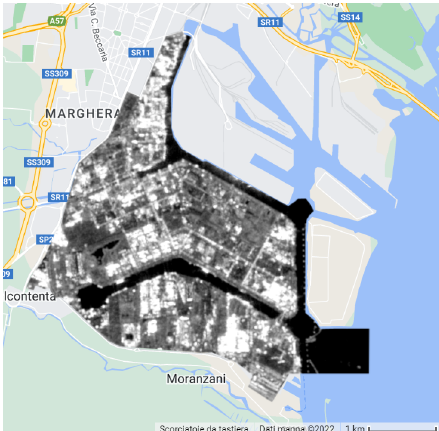
Figure 2. Sentinel-1 median image (Marghera dock, January-March 2019).